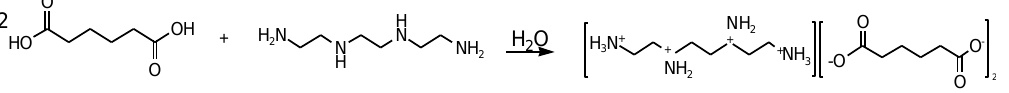
Figure 1. Principle of the synthesis of an adipic acid ammonium salt